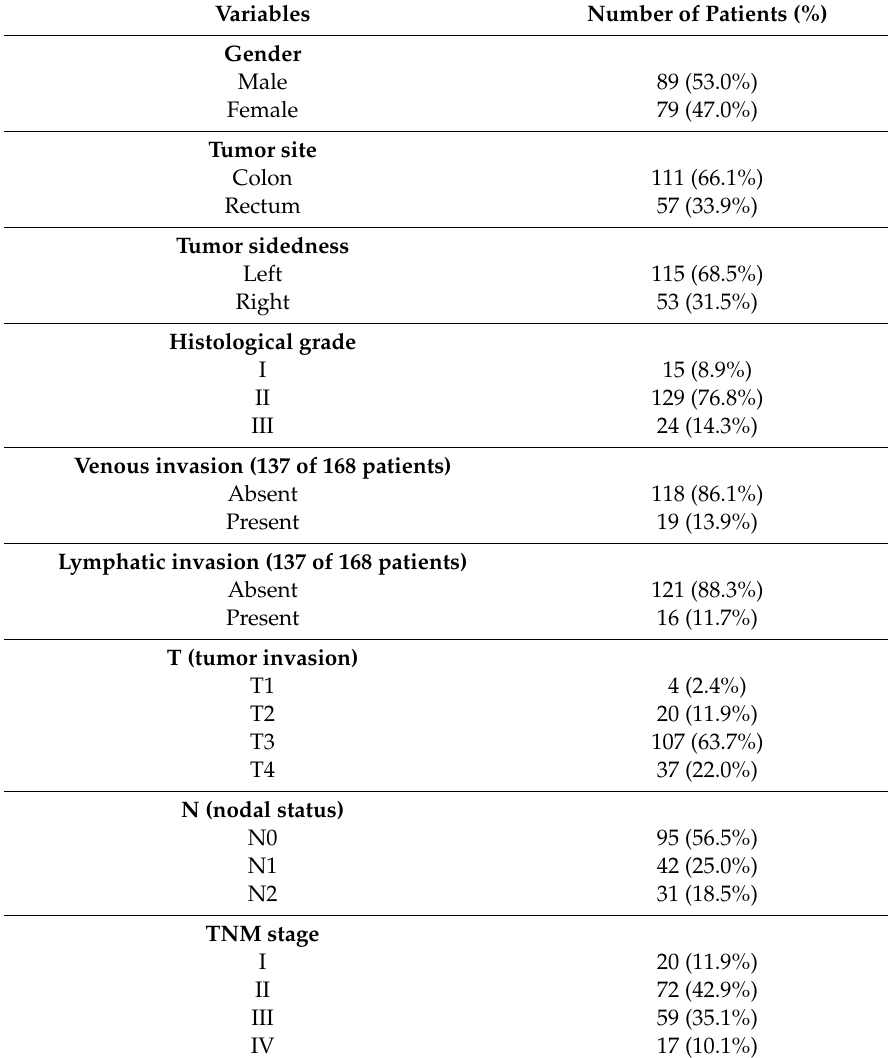
Table 5. Characterization of the 168 CRC